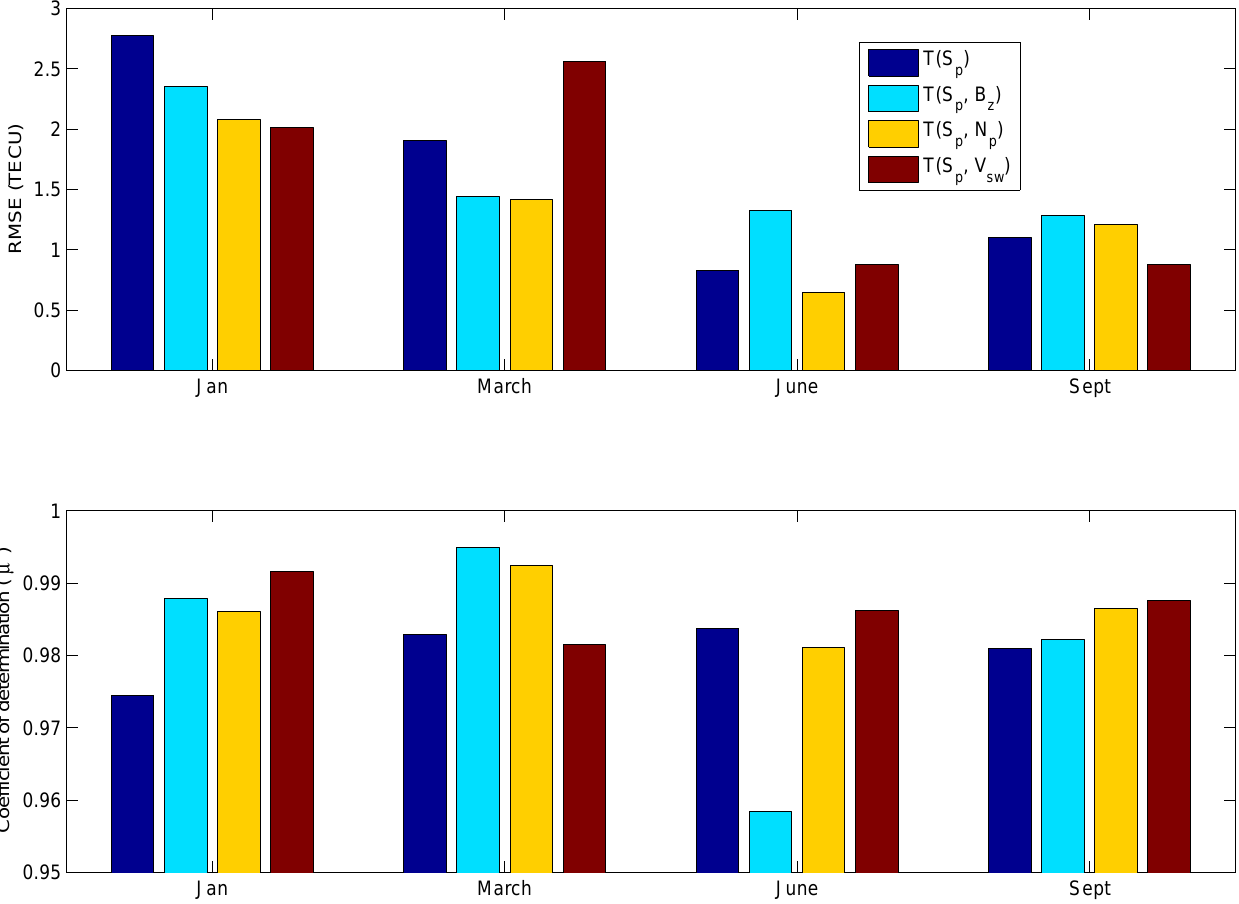
Fig. 13. Comparison of RMSE and coefficient of determination ( µ 2 ) values for the months representing autumn, winter, spring and summer in